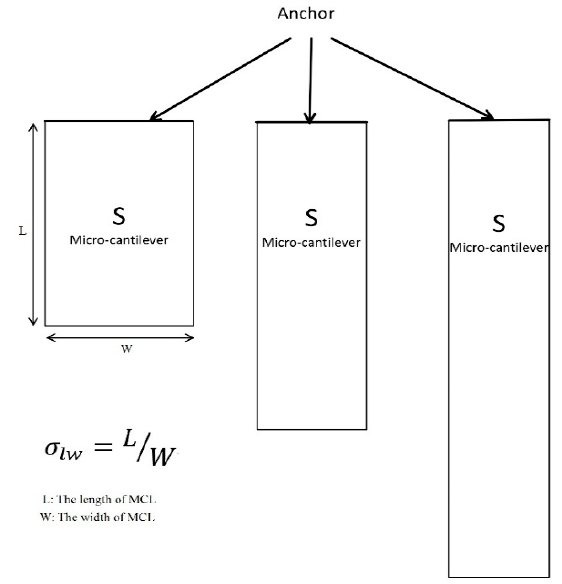
Figure 2. Top view of the MCLs geometry with different length to width ratios ( 𝜎 (cid:3039)(cid:3050) = 1, 2,3,4, 5, 6, 7, 8,9